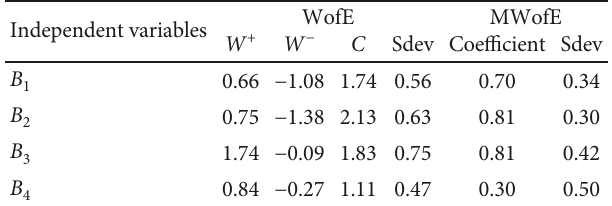
Table 7: Comparison of WofE weights and contrasts with MWofE coe ffi cients and their standard deviations (Sdev) in experiment